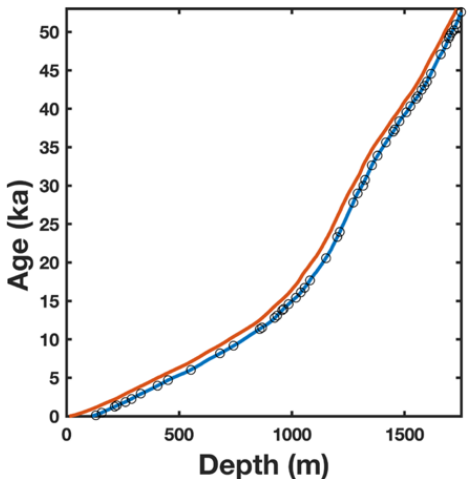
Figure 2. Ice age (orange) and gas age (blue) as a function of depth for the SP19 chronology. Gas tie points are indicated by black cir-